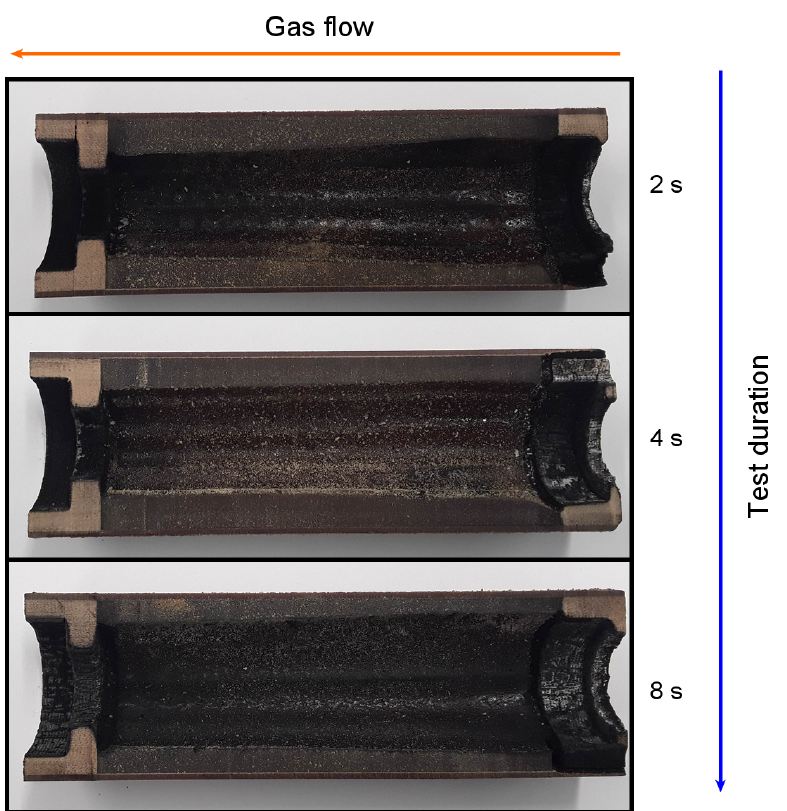
Figure 14. Sectional view of the star fuel blocks after the three different test